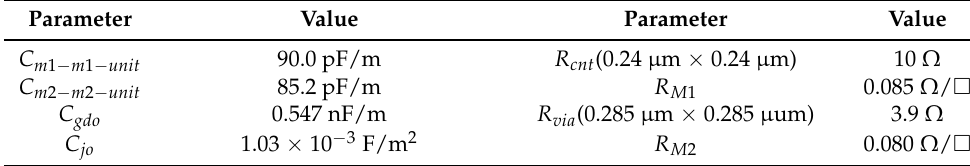
Figure 13. The layout of: ( a ) Traditional switch FET; ( b ) FET adopted in this work. In Table 2 are the parameters of the adopted process. Because the resistance intro- duced by via is small, the increase in on-resistance has a negligible effect on performance. But the parasitic capacitance is reduced by 12.06% according to (9), (10) and Table 2. As shown in the Figure 14, the ISO at 5 GHz of the switch with proposed layout is 1.5 dB better than that of the switch with traditional layout, and the degration of IL is negenactable. The improvement of ISO caculated with the 12.05% reduced parasitic capacitance is 1 dB, the difference is expected to result from the neglected capacitance in Equations (9) and (10). Table 2. Parameters for the adopted